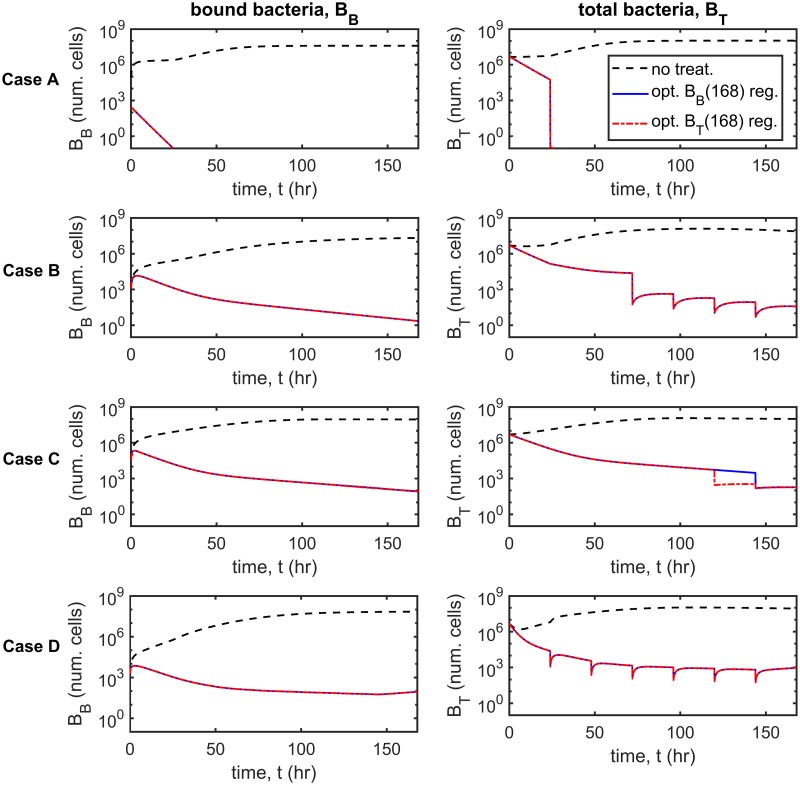
Optimum treatment outcomes—minimising final bacterial burdens with a new infection.Graphs show the dynamics of the bound and total bacterial burdens, BB and BT respectively (columns), in the untreated case and under the optimal treatment regimens (see Fig 9) for each parameter set (rows). Note the log10 scale on the y-axis. The bacterial burden is eliminated (BT(168) < 1) under the optimal treatment regimens in Case A and is significantly reduced in Cases B–D (to O(10) in Case B, O(102) in Case C and just below 103 in Case D). There is little difference in the effects of the optimum treatments under the different optimality conditions for any given case. Note that the discontinuities in BT are caused by the instantaneous removal of free bacteria upon debridement (similarly in Figs 12, 15 and 16, see Treatment types). Eqs 1–11 were solved using ode15s, with a constant antibiotic dose. Parameter values: A = 8 μg ml−1, λ = 0 cm3cell−1hr−1, ρ = 0 hr−1 and ω = 1. See Tables 2–4 for the remaining parameter values.